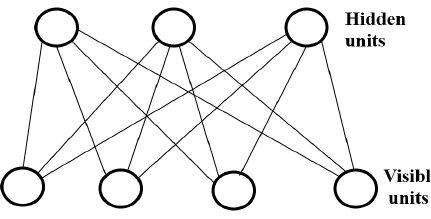
Figure 1. An example of a restricted Boltzmann machine